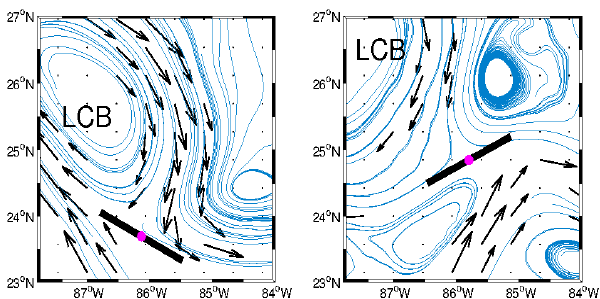
Fig. 7. Summary of the two different stages of the Loop Current Eddy (LCE) separation process :(a) Before separation. (b) After separation. The blue lines are the streamlines, the black arrows are the velocity vectors, the black line is the LCBsd associated with the LCBhp (dot in magenta). The orientation of the strain directions is determined by the relative positions of the LCB and the LC (see text).